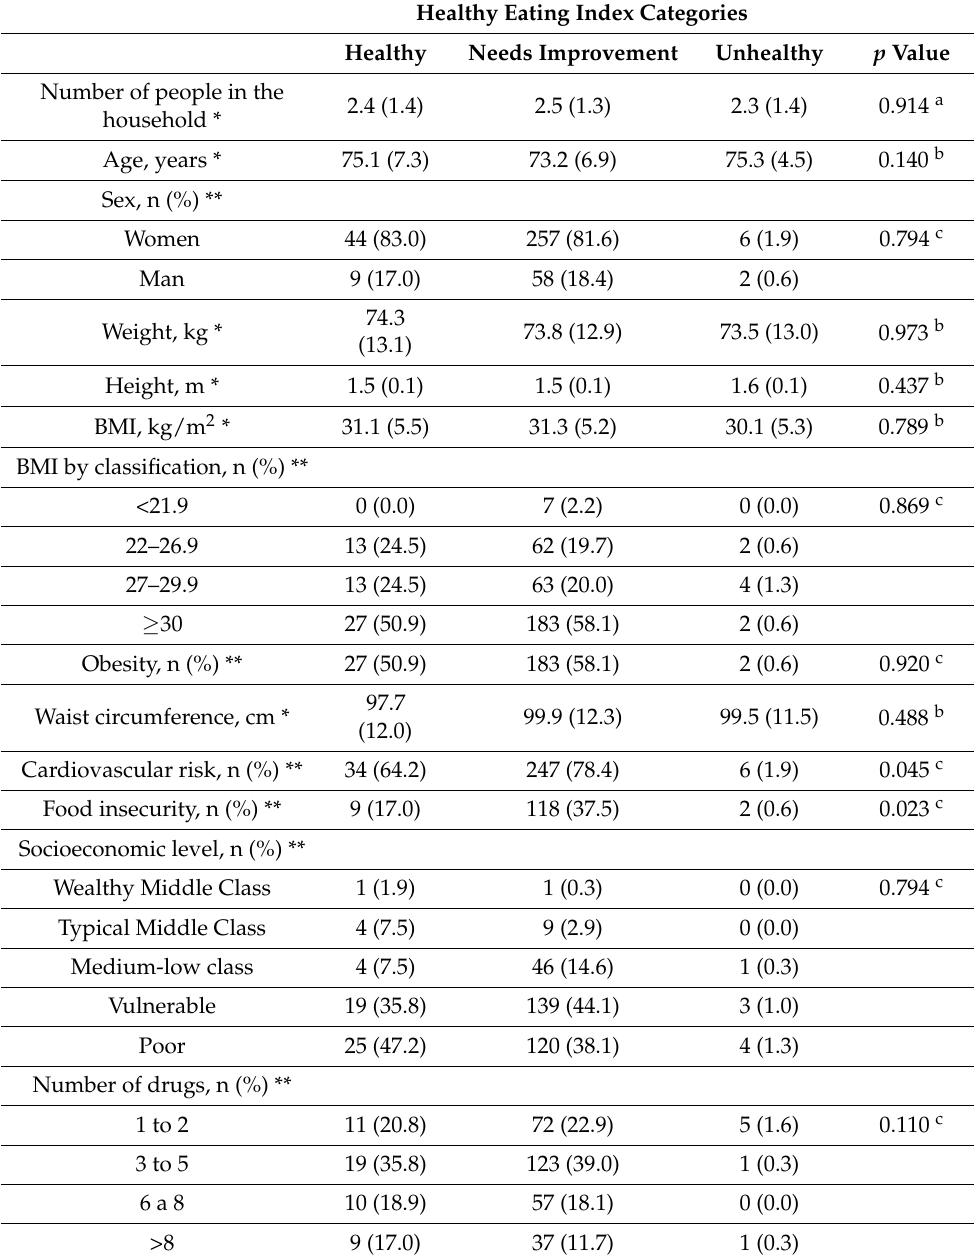
Table 2. Comparisons of demographic characteristics according to quality of diet